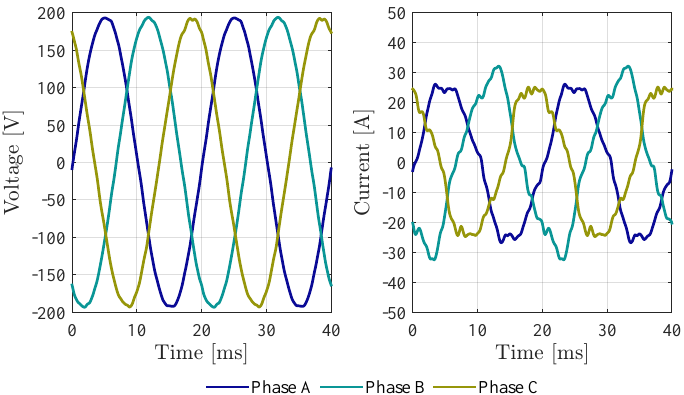
Figure 15. Voltage and current waveforms for scenario (1): balancing three-phase current from the consumptions.